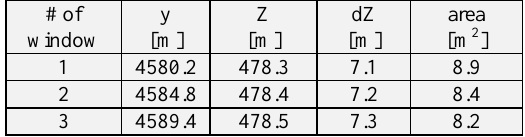
Table 4. Derived information on the windows of the rearmost façade (y, Z=façade coordinates of centre, dZ=height of centre above